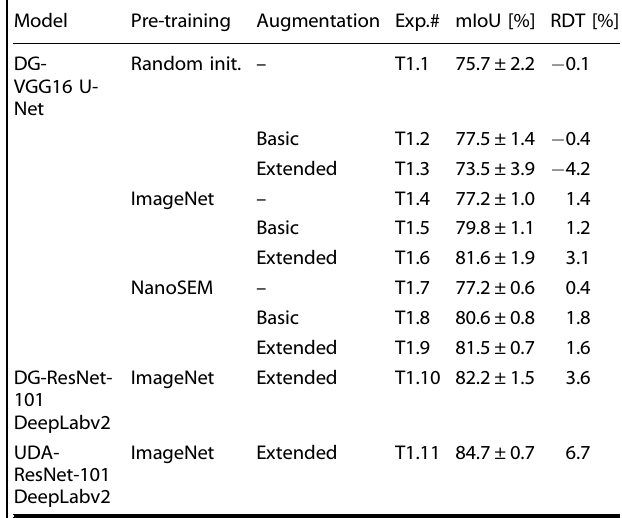
Table 2. Performance of the models trained on the source domain evaluated on the target 1 domain along with the UDA reached performance.